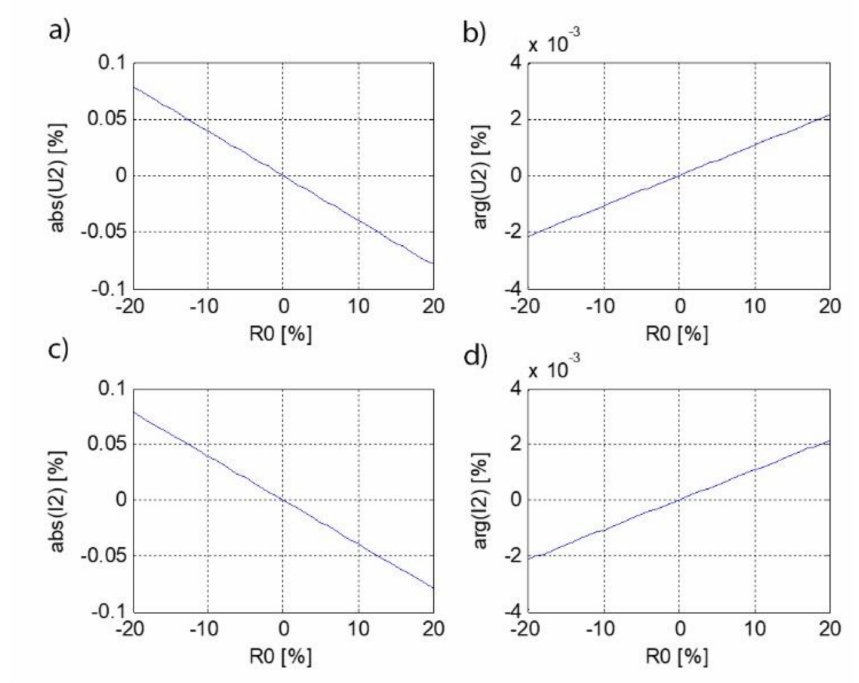
Figure 15. Changes of wave parameters depending on R 0 at f = 500 kHz; ( a ) U 2 voltage modulus, ( b ) U 2 argument, ( c ) I 2 modulus, ( d ) I 2 argument.